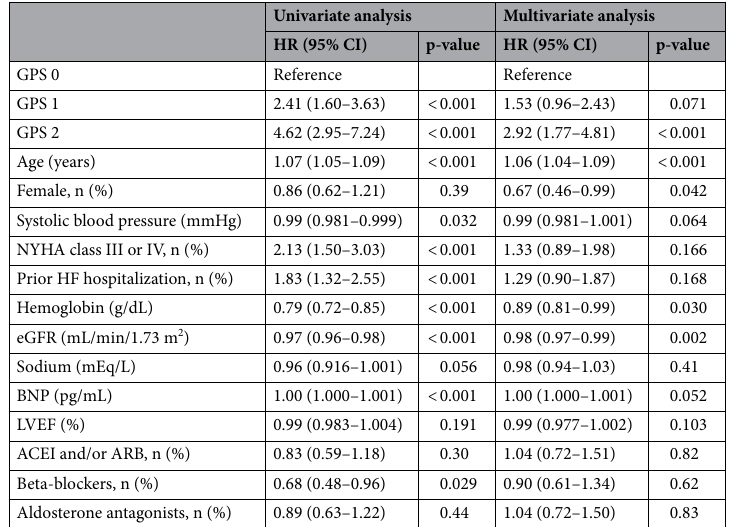
Table 3. Univariate and multivariate cox proportional hazards analysis to identify prognostic ability of the GPS. Data presented are hazard ratios and 95% confidence intervals. ACEI angiotensin-converting enzyme inhibitor, ARB angiotensin-receptor blocker, BNP B-type natriuretic peptide, CI confidence interval, eGFR estimated glomerular filtration rate, GPS Glasgow Prognostic Score, HF heart failure, HR hazard ratio, LVEF left ventricular ejection fraction, NYHA New York Heart Association.